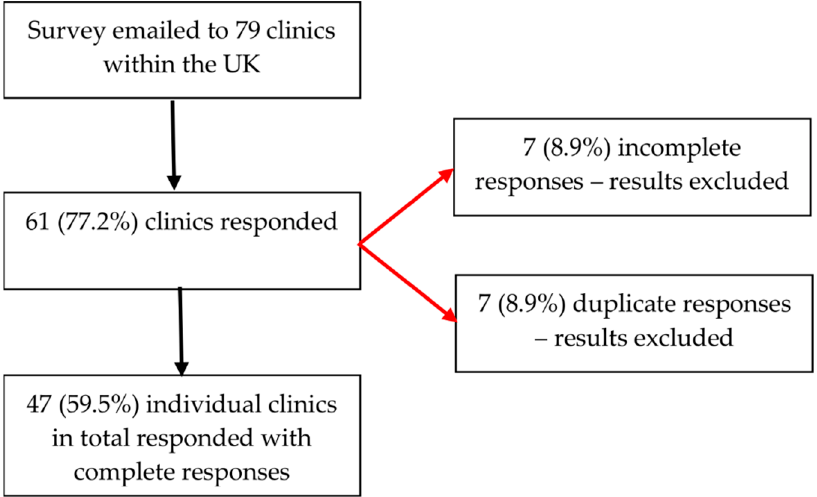
Figure 1. Flowchart of survey respondents.